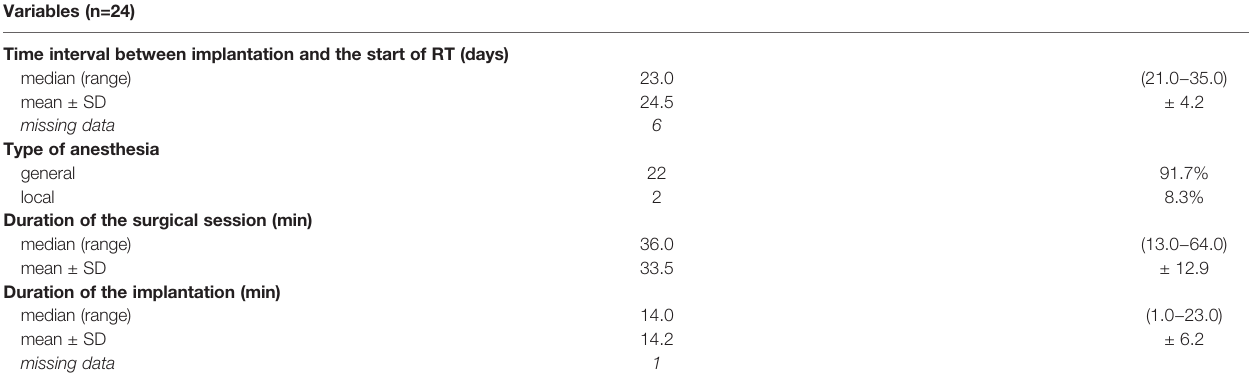
TABLE 2 | Characteristics of the ProSpace ® balloon